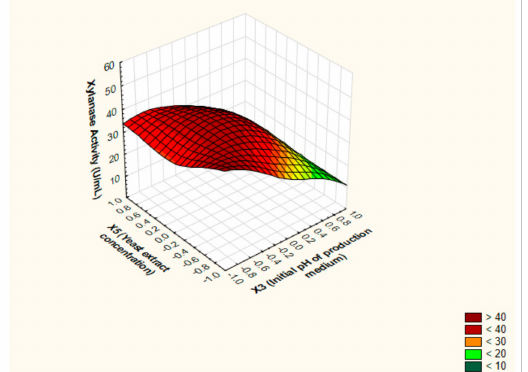
Figure 7. The 3D surface plot depicting the influence of yeast extract concentration (%( w / v )) and initial pH of the production medium at a fixed value of WS concentration (%( w / v )) on the production of xylanase from P. chrysogenum A3 DSM105774 in submerged state